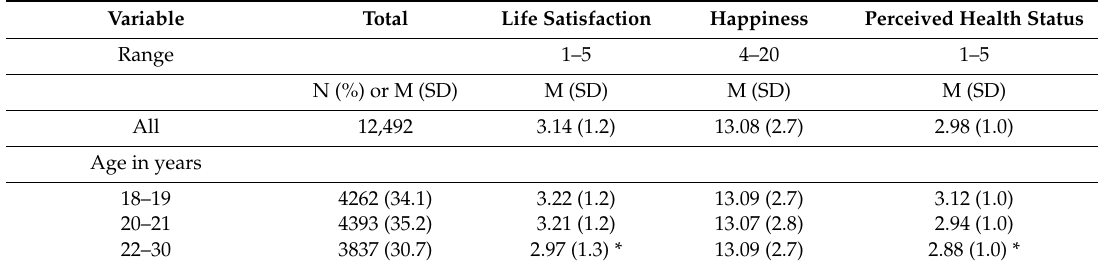
Table 1. Sample characteristics and well-being